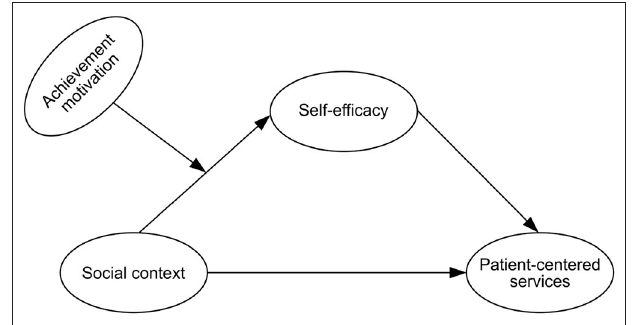
FIGURE 1 | Research model diagram of medical professionals’ patient-centered service